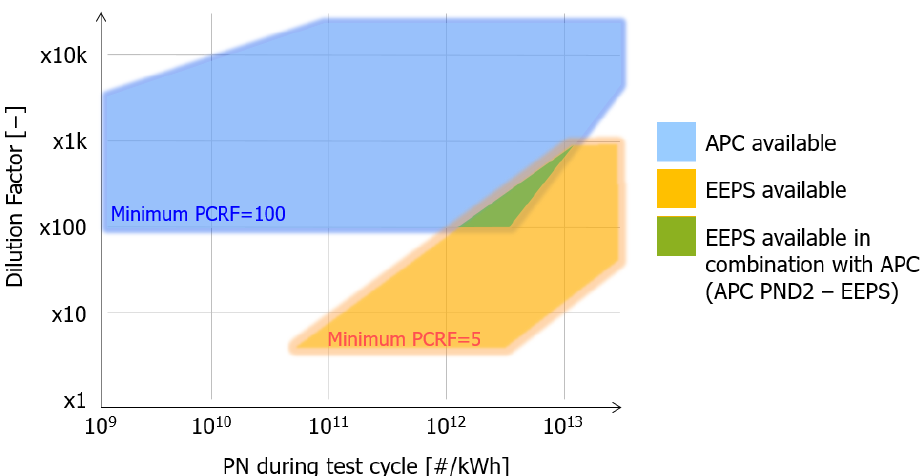
Figure 3. Overlapping dilution factor areas of APC and EEPS. APC = AVL Particle Counter; CPC = Condensation Particle Counter; PND = Particle Number Diluter; EEPS = Engine Exhaust Particle Sizer; PCRF= Particle number concentration reduction factor.